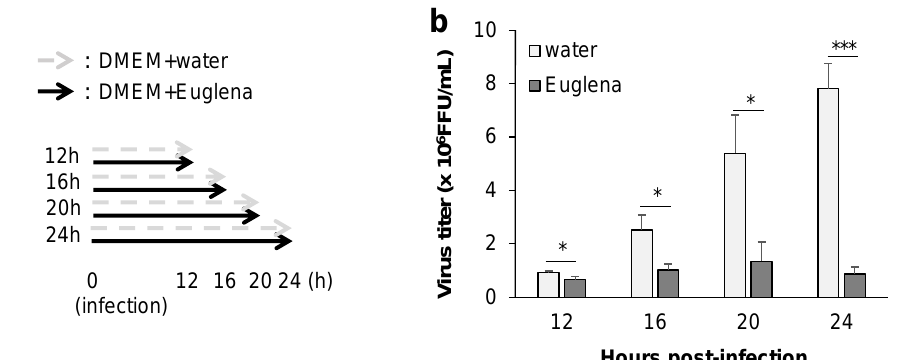
Figure 3. Dependence of the anti-influenza effect of Euglena extract on the treatment duration. ( a ) Protocol. ( b ) Virus titer following the incubation of Madin–Darby canine kidney cells with Euglena extract for 12, 16, 20, and 24 h after viral infection. The error bars indicate standard deviations ( n = 3); * p < 0.05, *** p < 0.001. FFU: focus-forming units.